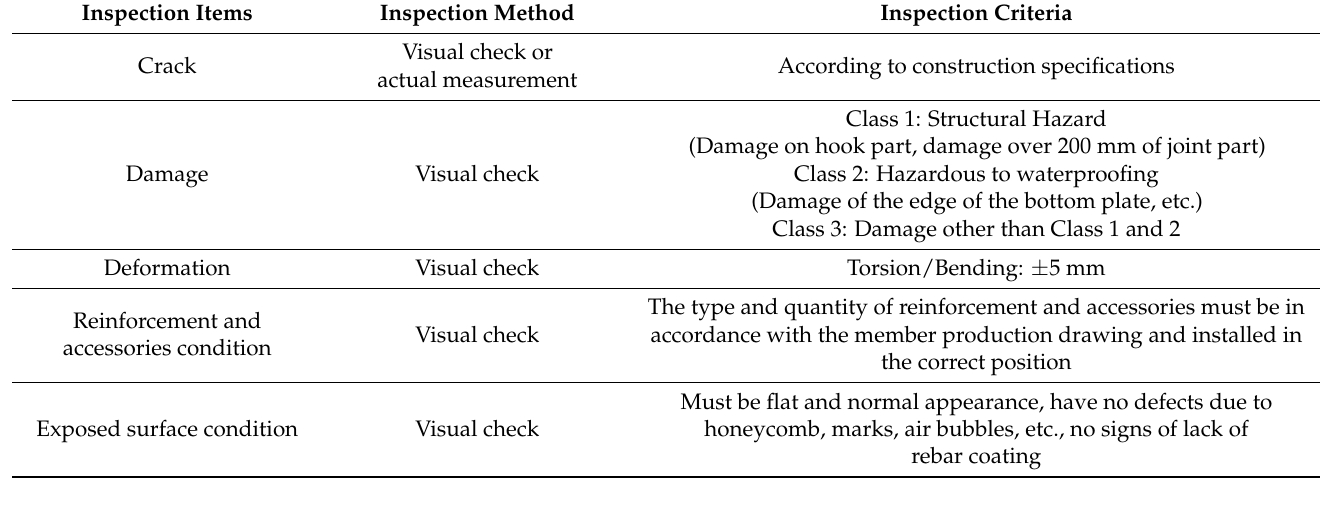
Table 1. Major quality inspection items, inspection methods, and criteria.